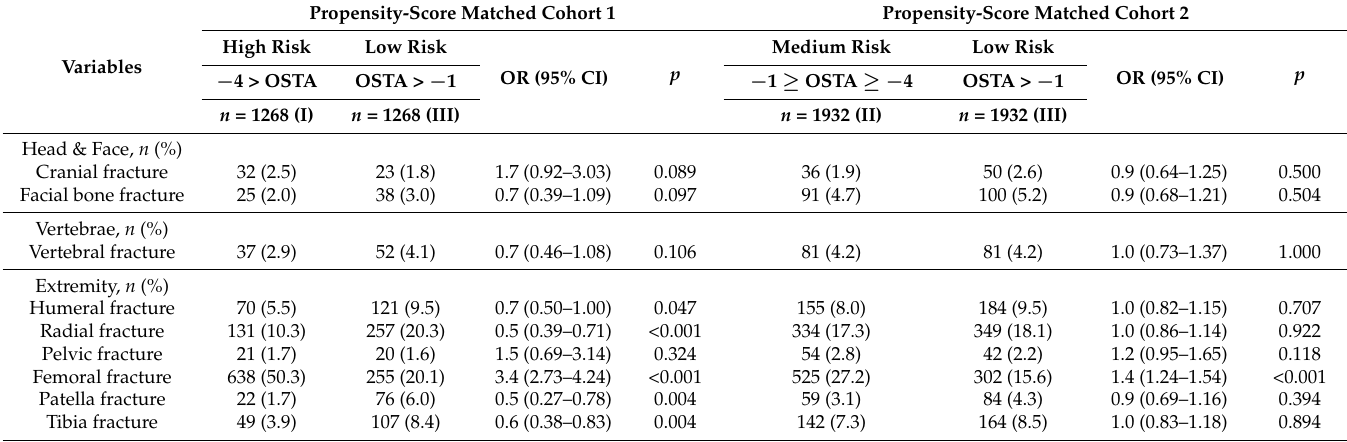
Table 4. Associated fracture sites of propensity-score matched populations with high-risk (OSTA < − 4), medium-risk ( − 1 ≥ OSTA ≥ − 4), and low-risk (OSTA > − 1) to